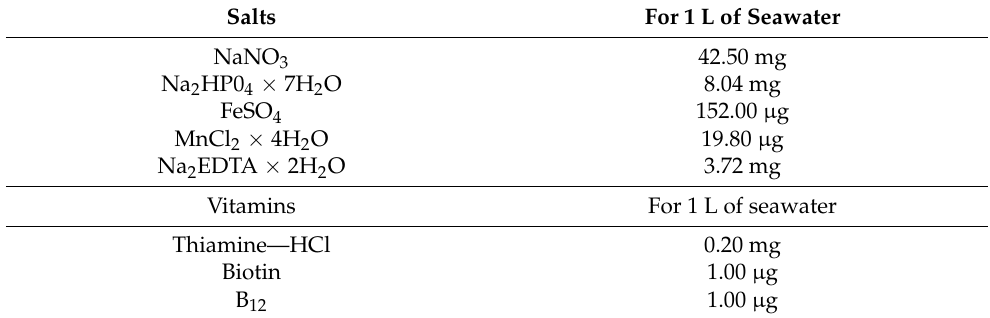
Table 1. The modified Von Stosch’s enriched seawater medium used for the growth of P. leucosticta